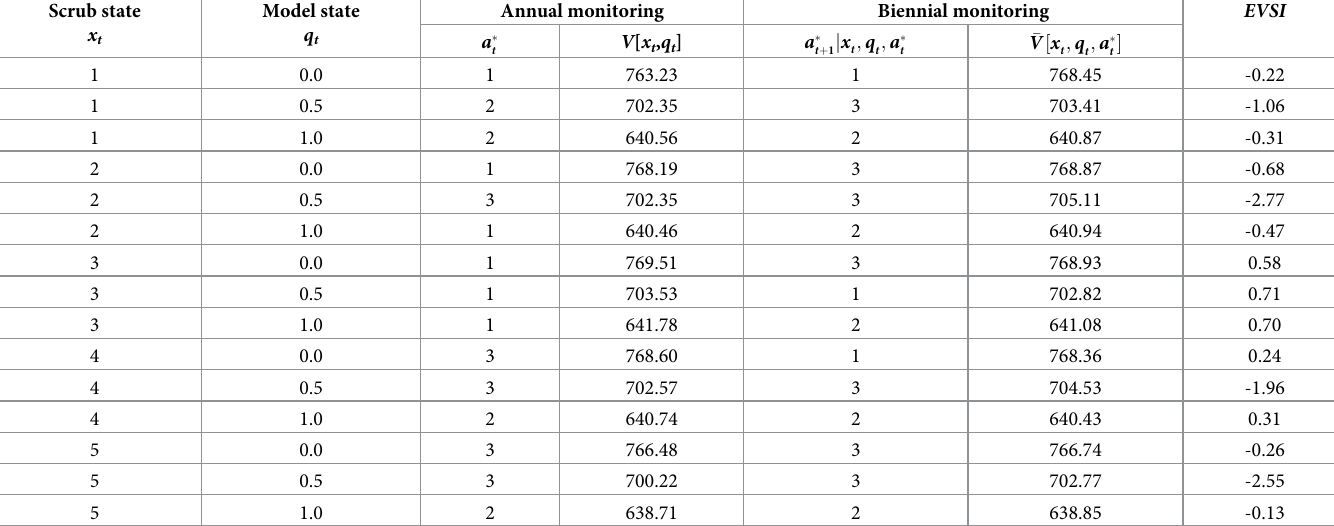
Table 2. Optimal actions ( a � ) and cumulative values ( V ) over 2000 time steps for managing habitat for Florida scrub-jays under annual and biennial monitoring schemes. The Expected Value of Sample Information ( EVSI) is the difference in expected performance between the two monitoring schemes. Scrub states x t are: (1) short- open; (2) short-closed; (3) optimal-open; (4) optimal-closed; and (5) tall-mix. Model state q is the probability of the null model, which posits that an intensive burn is no t more effective at restoring optimal height scrub than a routine burn. Optimal actions a � are: (1) do nothing; (2) routine burn; and (3) intensive burn. Sometimes the